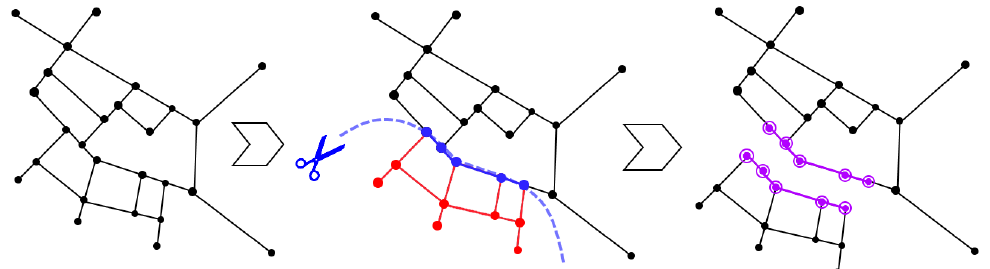
Figure 1. Complementary graphs: centralised graph ( left ); dividing line passing through nodes ( centre ); distributed representation with border nodes ( right ).